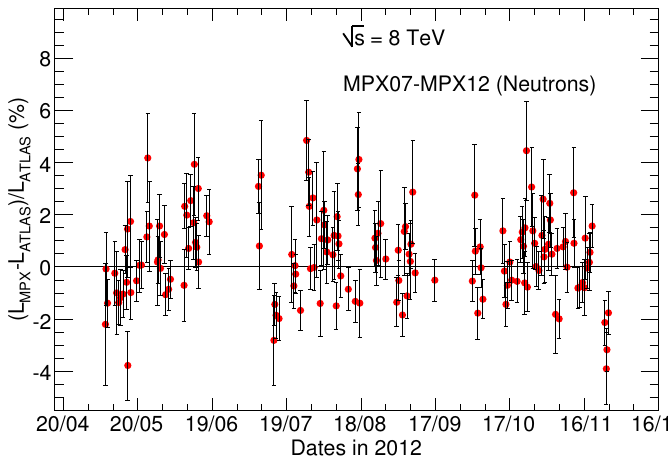
Figure 29. Evolution in time of the fractional difference in run-integrated luminosity between the MPX neutron-counting and the ATLAS reference luminosity. Each point shows the mean difference for a single run as defined in the text. The error bars are statistical only and convoluted with 0.5% relative uncertainty from the ATLAS reference measurement. The MPX neutron luminosity is normalized to the MPX hit luminosity [11] such that their ratio for the data taken on 16 September 2012 is unity. The data of the devices MPX07-MPX12 are combined. Taken from Ref. [13].